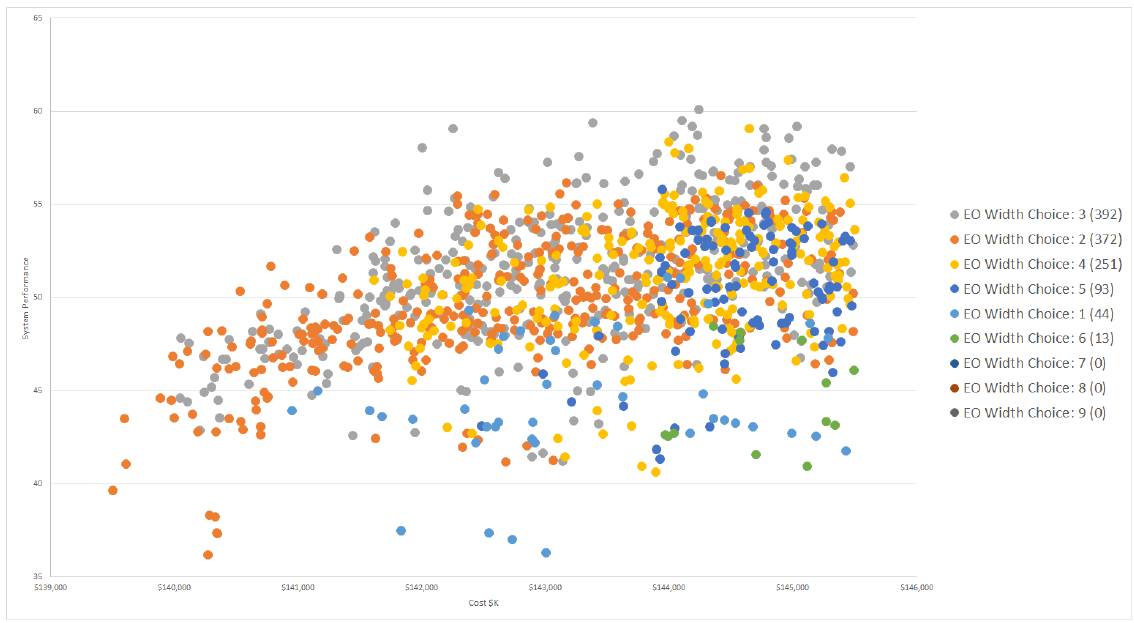
Figure 13. Original UAV Tradespace with Electro-Optical Sensor Width Choice as Set Driver.